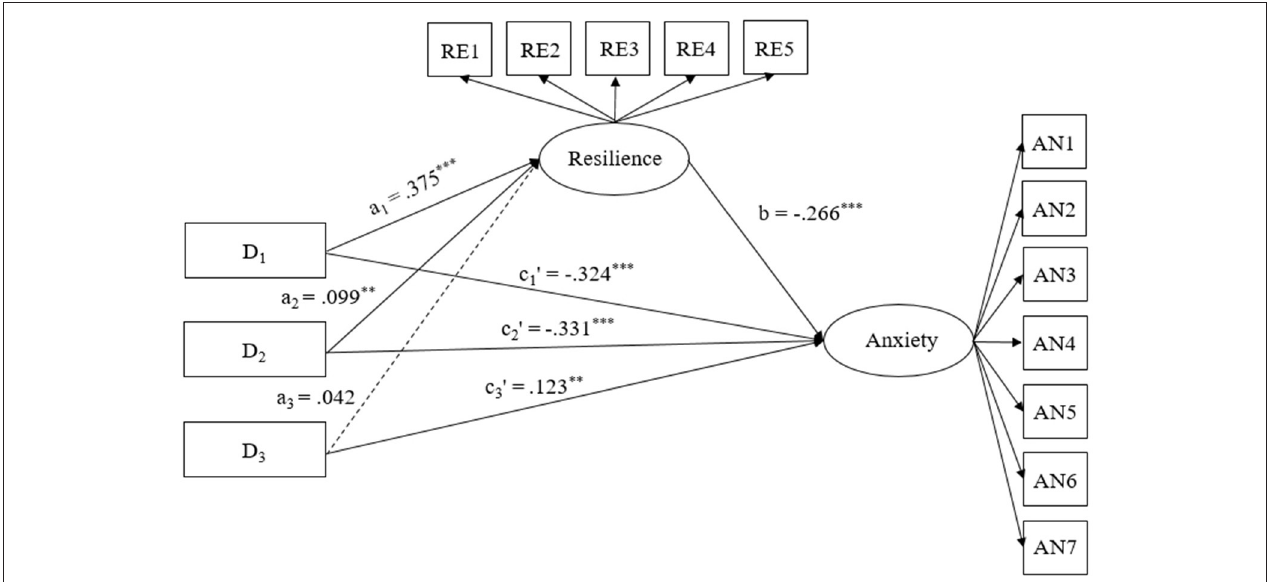
FIGURE 2 | Model of the mediation role of resilience in association between perceived stress profiles and anxiety. D 1 , D 2 , and D 3 were dummy variables to represent the perceived stress profiles. The resistant profile served as the reference group and were assigned a score of “0” across the three variables. The adaptive, insensitive, and sensitive profiles were assigned with respective scores of “100,” “010,” and “001” across D 1 , D 2 , and D 3 . RE1-RE5 = five parcels of resilience; AN1-AN7 = seven items of anxiety. *** p <